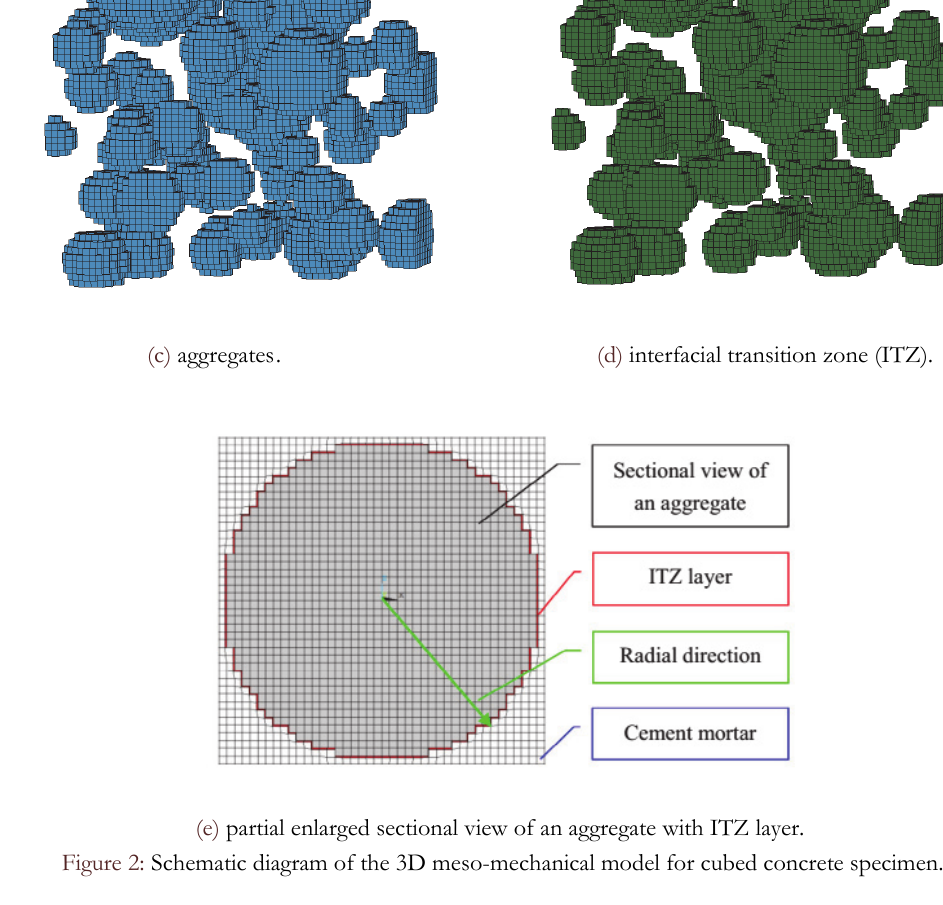
Figure 2: Schematic diagram of the 3D meso-mechanical model for cubed concrete